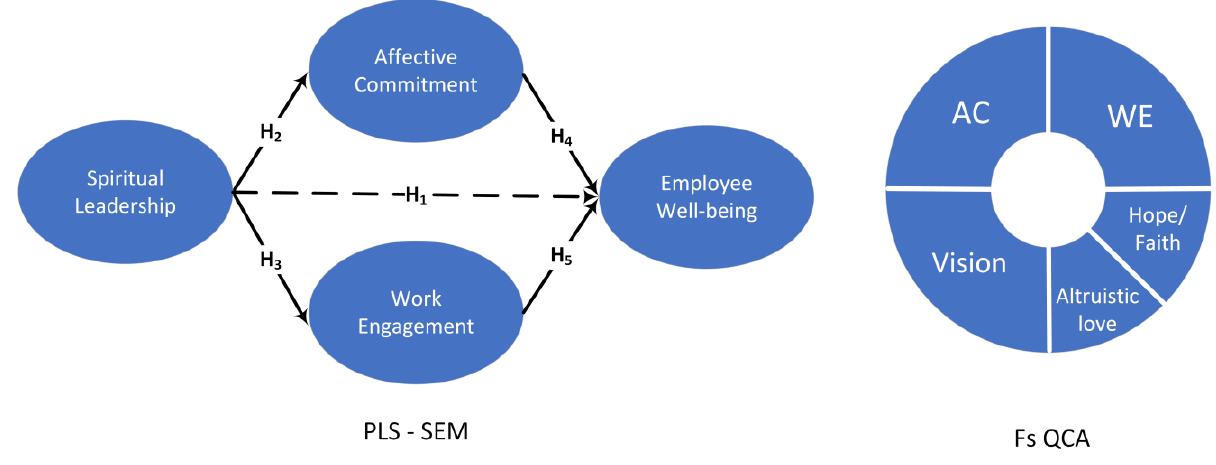
Figure 1. Proposed research model and